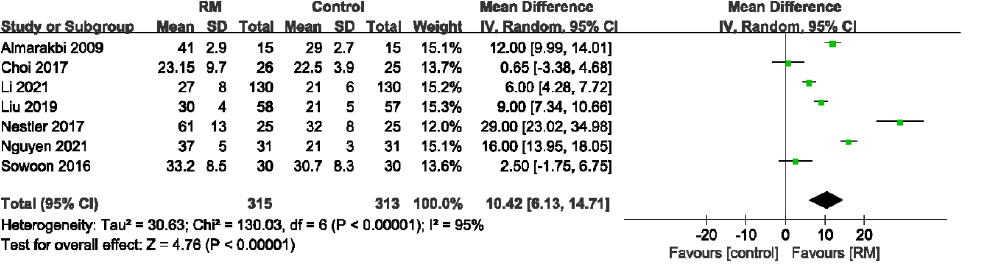
Figure 10. Forest plot for static lung compliance between RM and control groups [16,18,21,22,24,25,29].